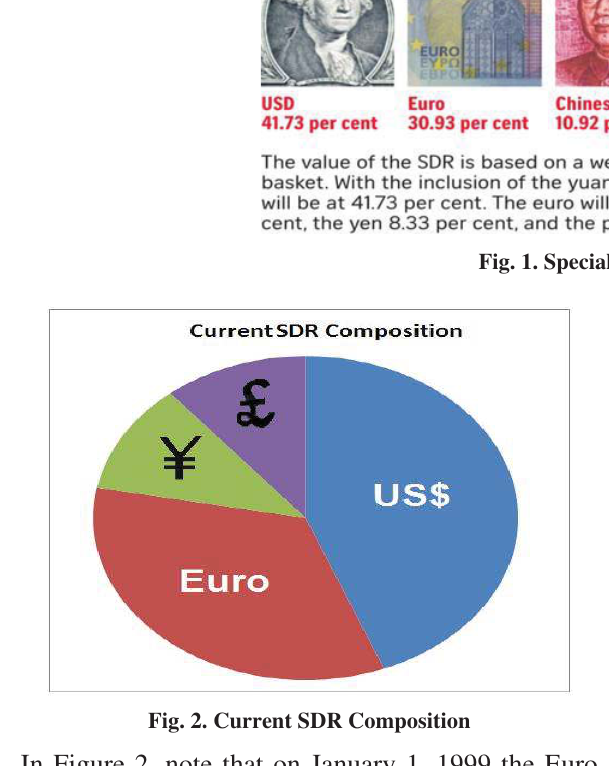
Fig. 2. Current SDR Composition